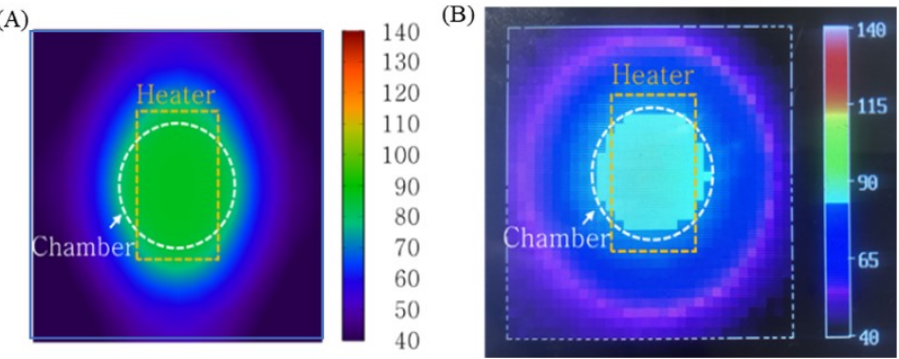
Figure 7. ( A ) Simulation result visualizing the temperature distribution on the surface of the mi- crochip ( B ) Thermal image of the microchip surface using a thermal imaging camera. The temperature profile of the sample inside the chamber was